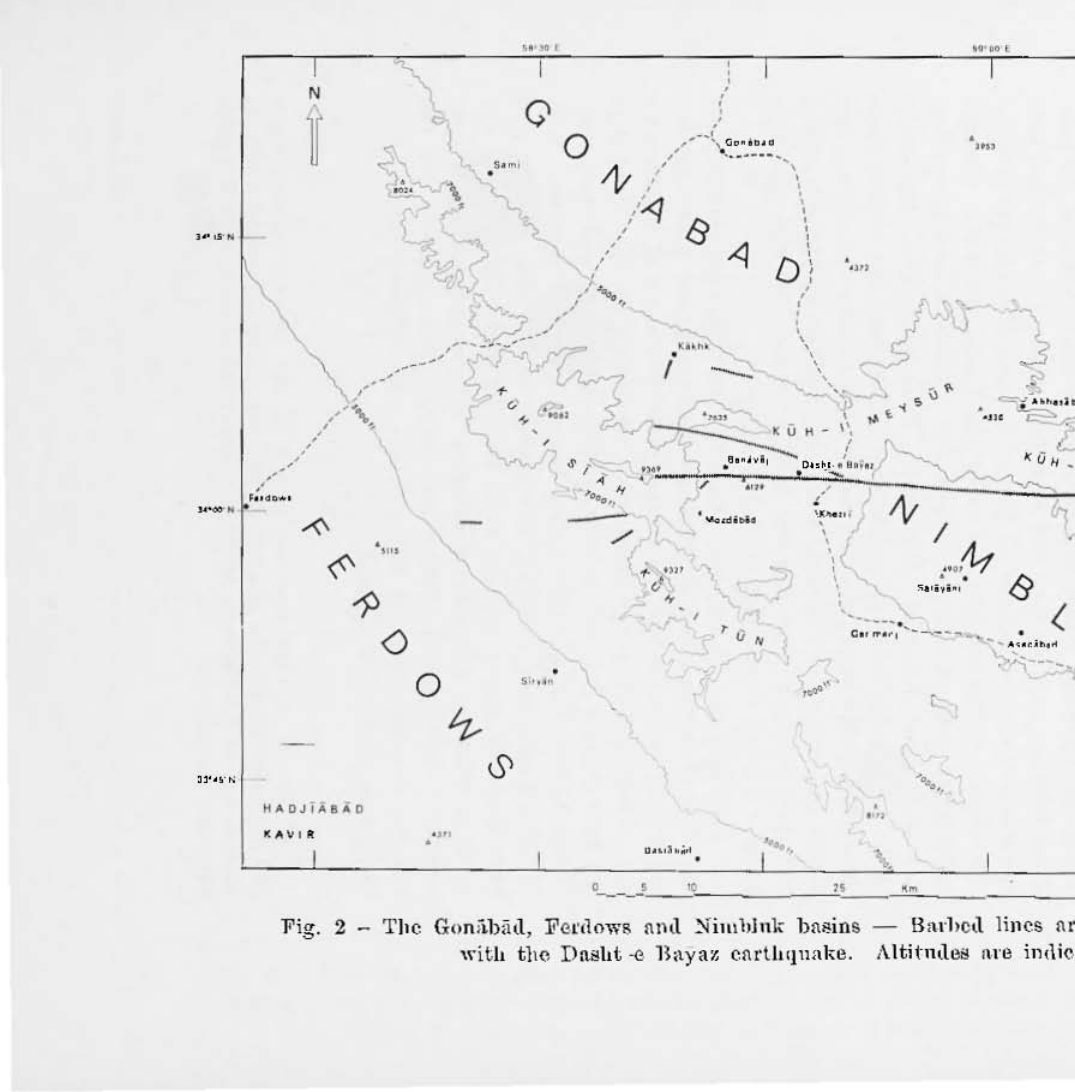
- IbrhCII lillCS nrG slll'facc ra ult.ing Altitnllei! lire indicntcll in fcct.